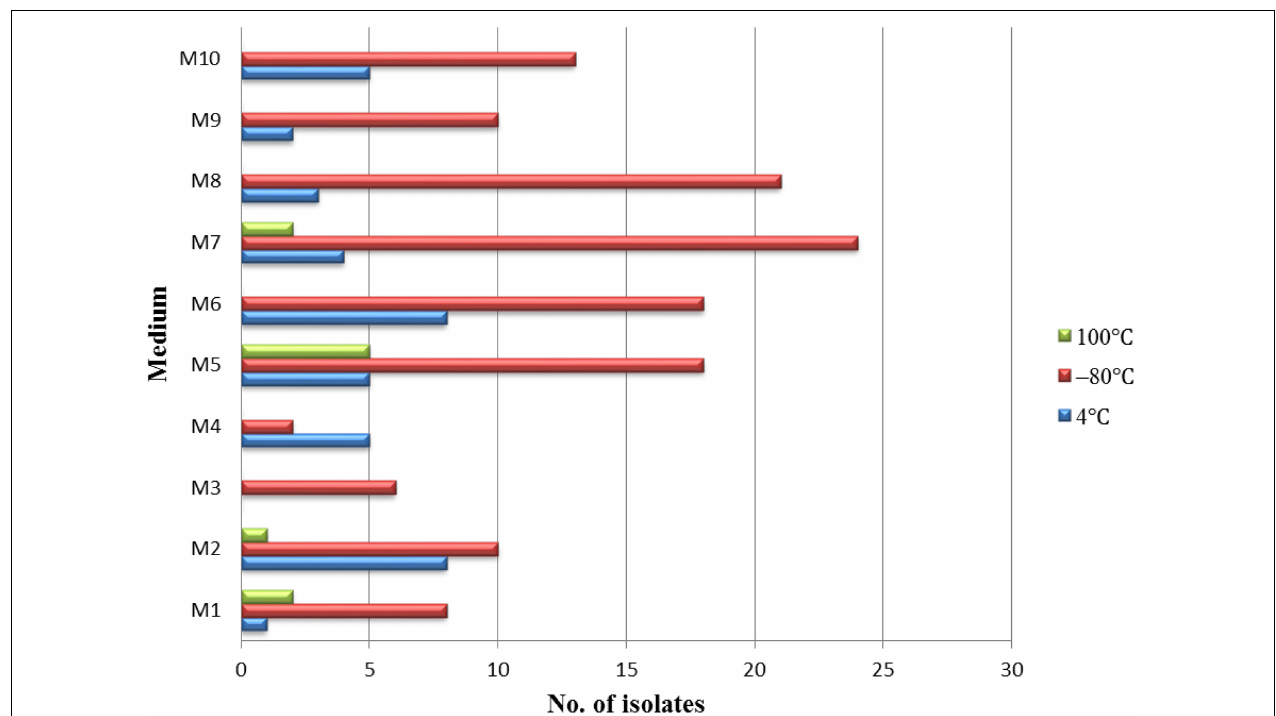
FIGURE 2 | The isolation effectiveness of endophytes under the different pretreatments and medium.